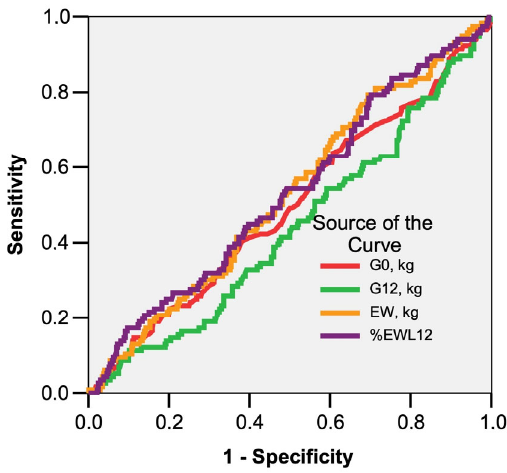
Figure 4. Initial weight and excess weight as predictors of T2DM total remission. The mean preoperative weight was significantly higher in patients with apnoea than in those without apnoea (133.55 vs. 123.31 kg; p = 0.001). Lower follow ‐ up weight loss is also identified throughout the monitoring. One year after the procedure, the average weight remained significantly higher in patients with apnoea syndrome (92.41 vs. 86.45 kg; p = 0.003), but the percentage of weight lost at 12 months (%EWL12) did not differ significantly compared to patients without apnoea syndrome ( p > 0.05).